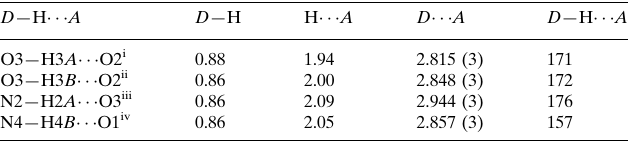
Hydrogen-bond geometry (A˚ , (cid:2)